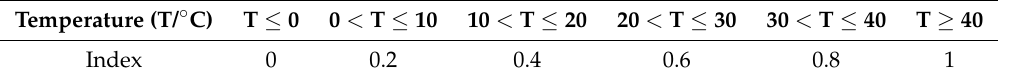
Table 3. Quantization for the factors of